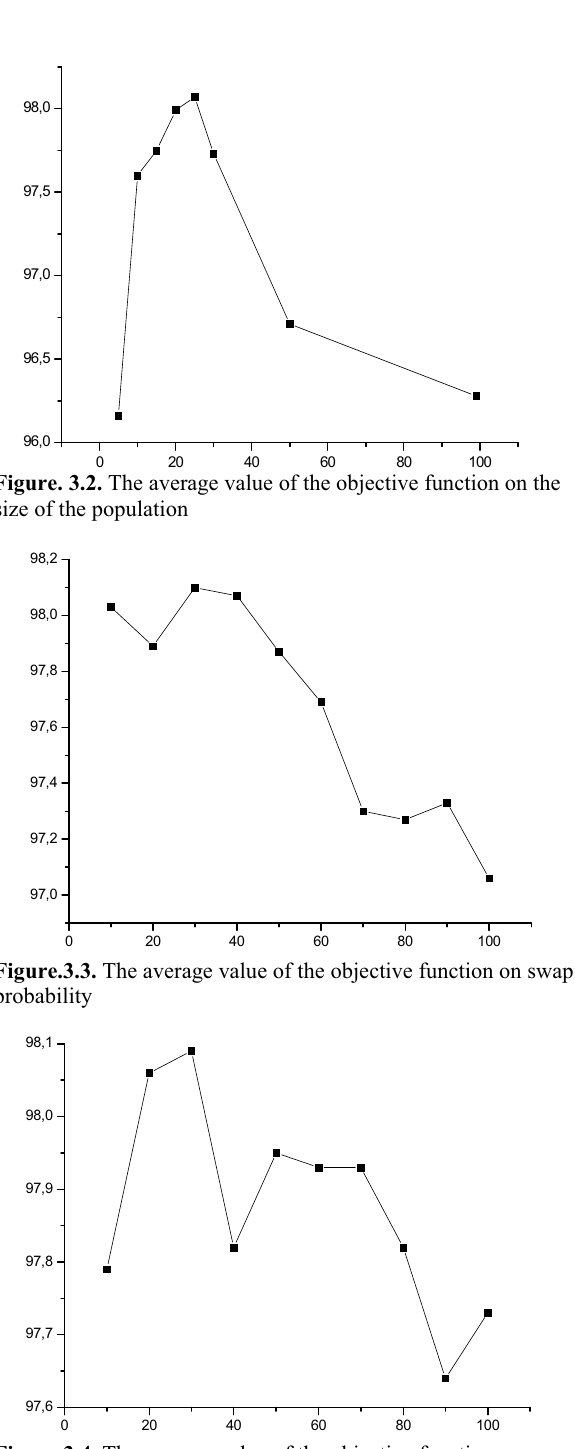
Figure.3.4. The average value of the objective function on crossing probability